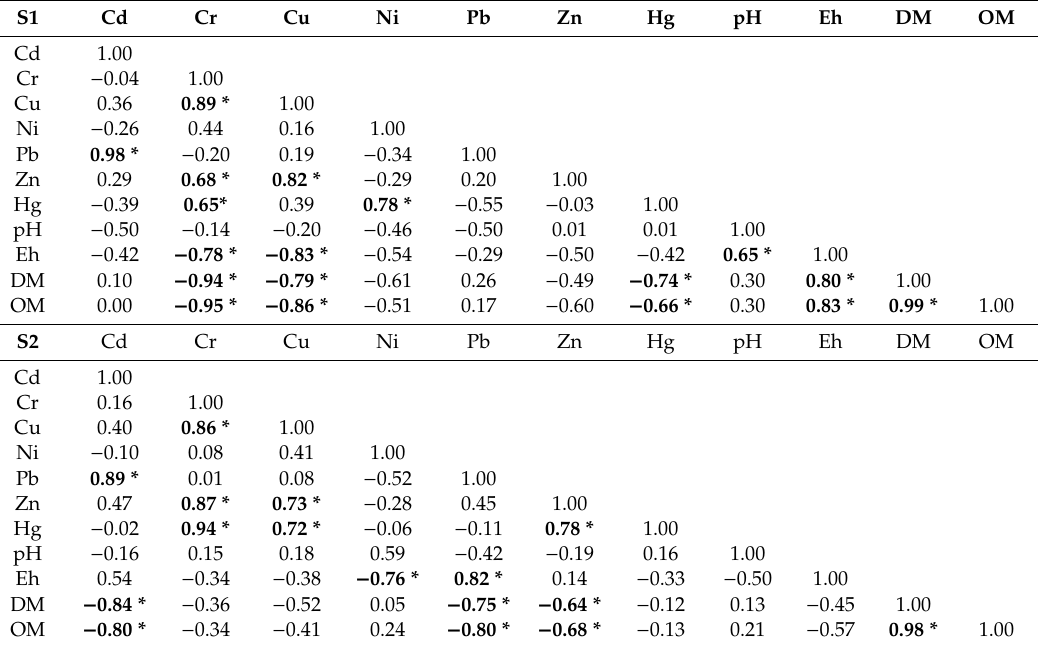
Table 9. Pearson’s correlation matrix for the analyzed